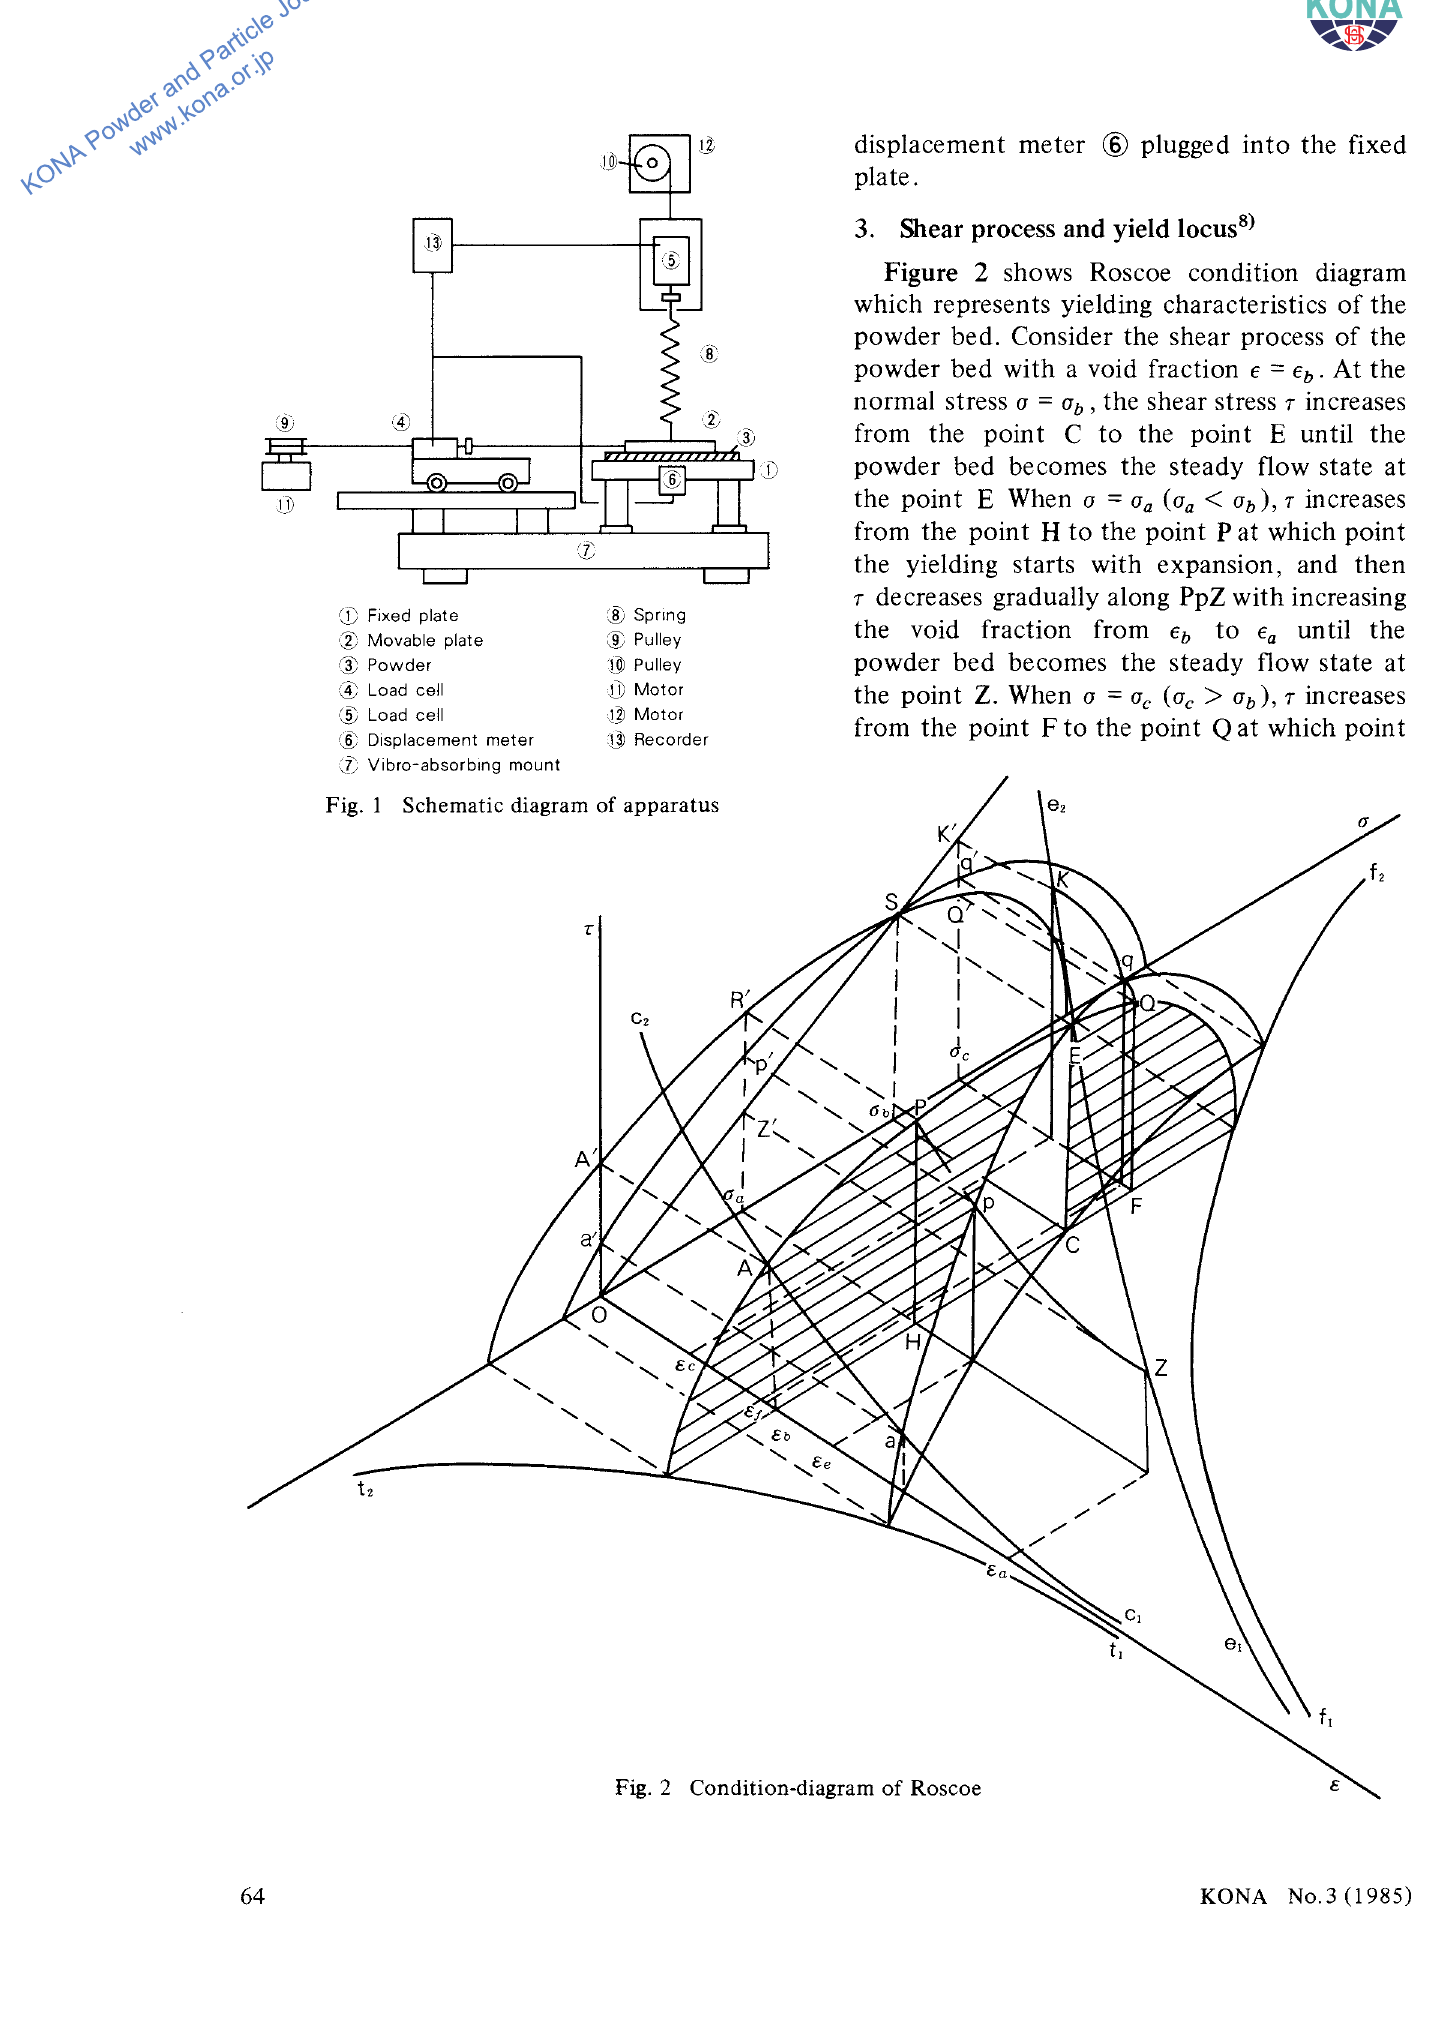
Fig. 2 Condition-diagram of